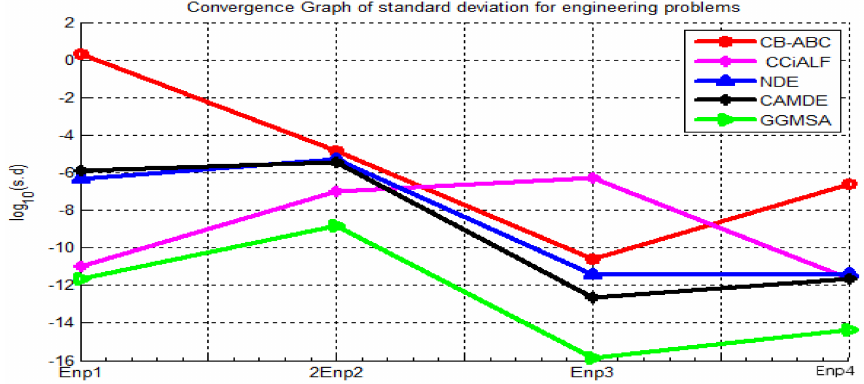
Figure 11. Convergence graph of standard deviation for Enp1 to